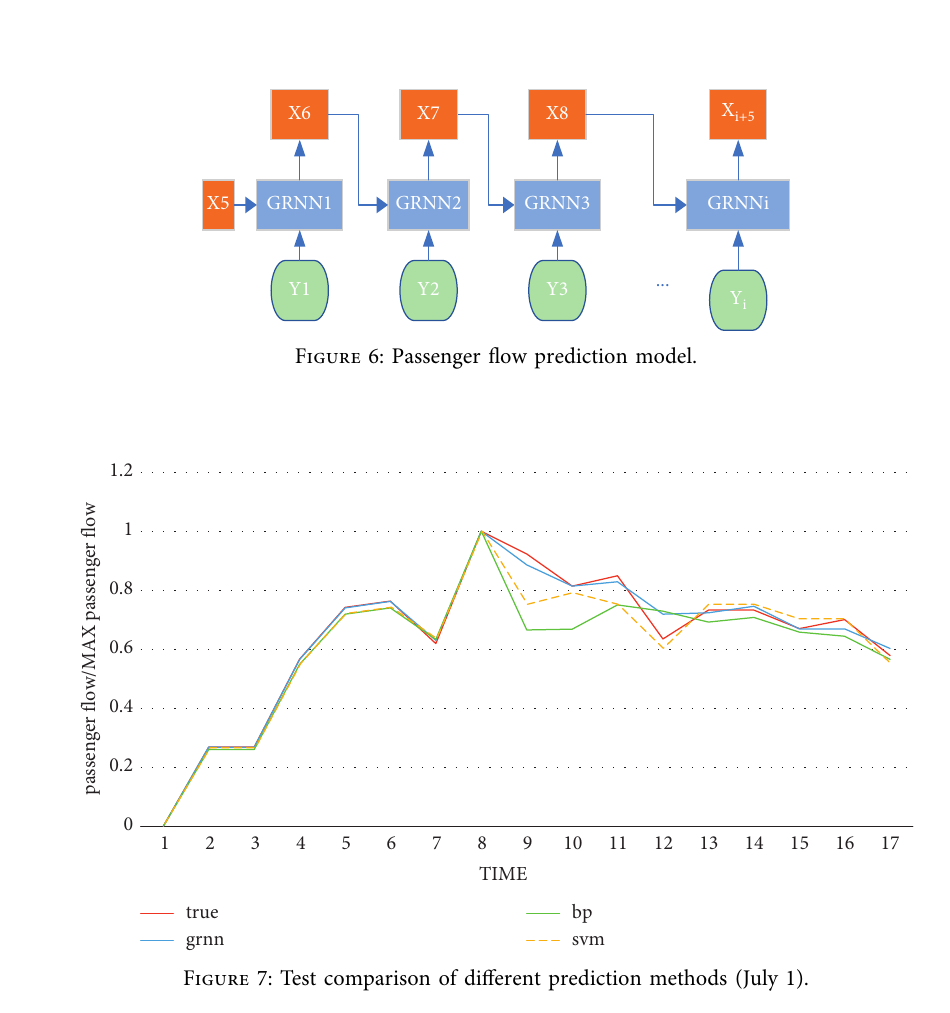
Figure 5: Passenger flow forecasting data input and output.